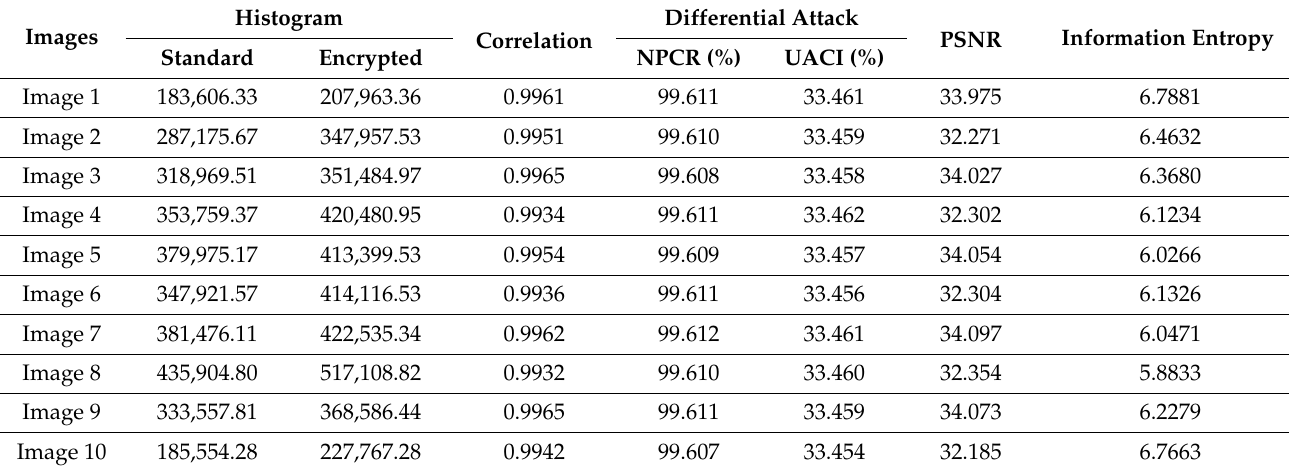
Table 4. Statistical metrics for CT Modality (Gaussian noise with 0.006 variance).